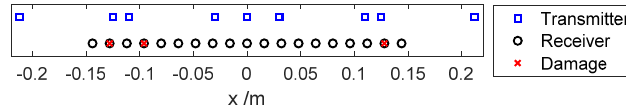
Figure 12. The experimental scenario: ( a ) Photograph of a vector network, a console and a computer; ( b ) Photograph of a customized scanning rack; ( c ) Photograph of a man model with a coat; ( d ) Photograph of a man model tied to a gun.